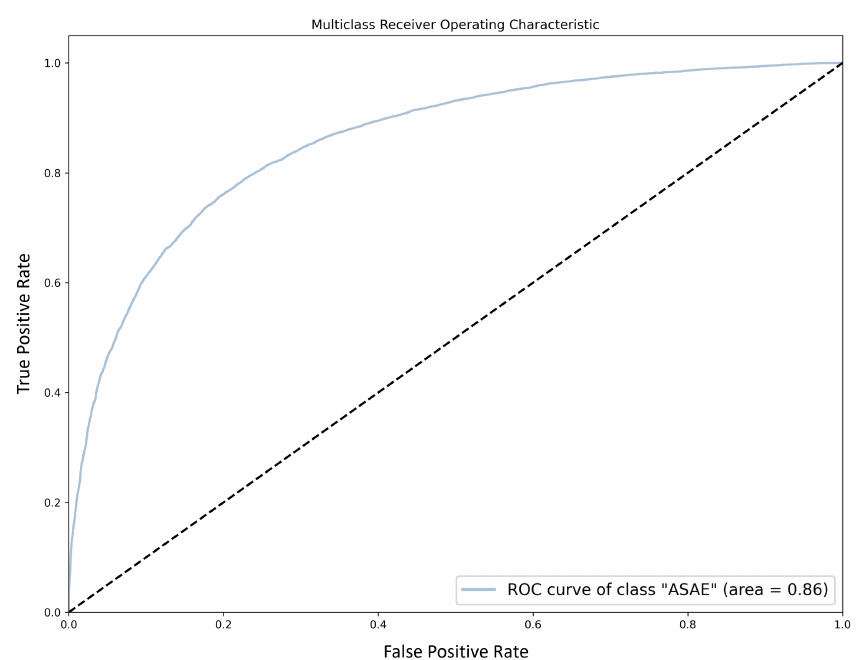
Figure 4. ROC curve for competence prediction using